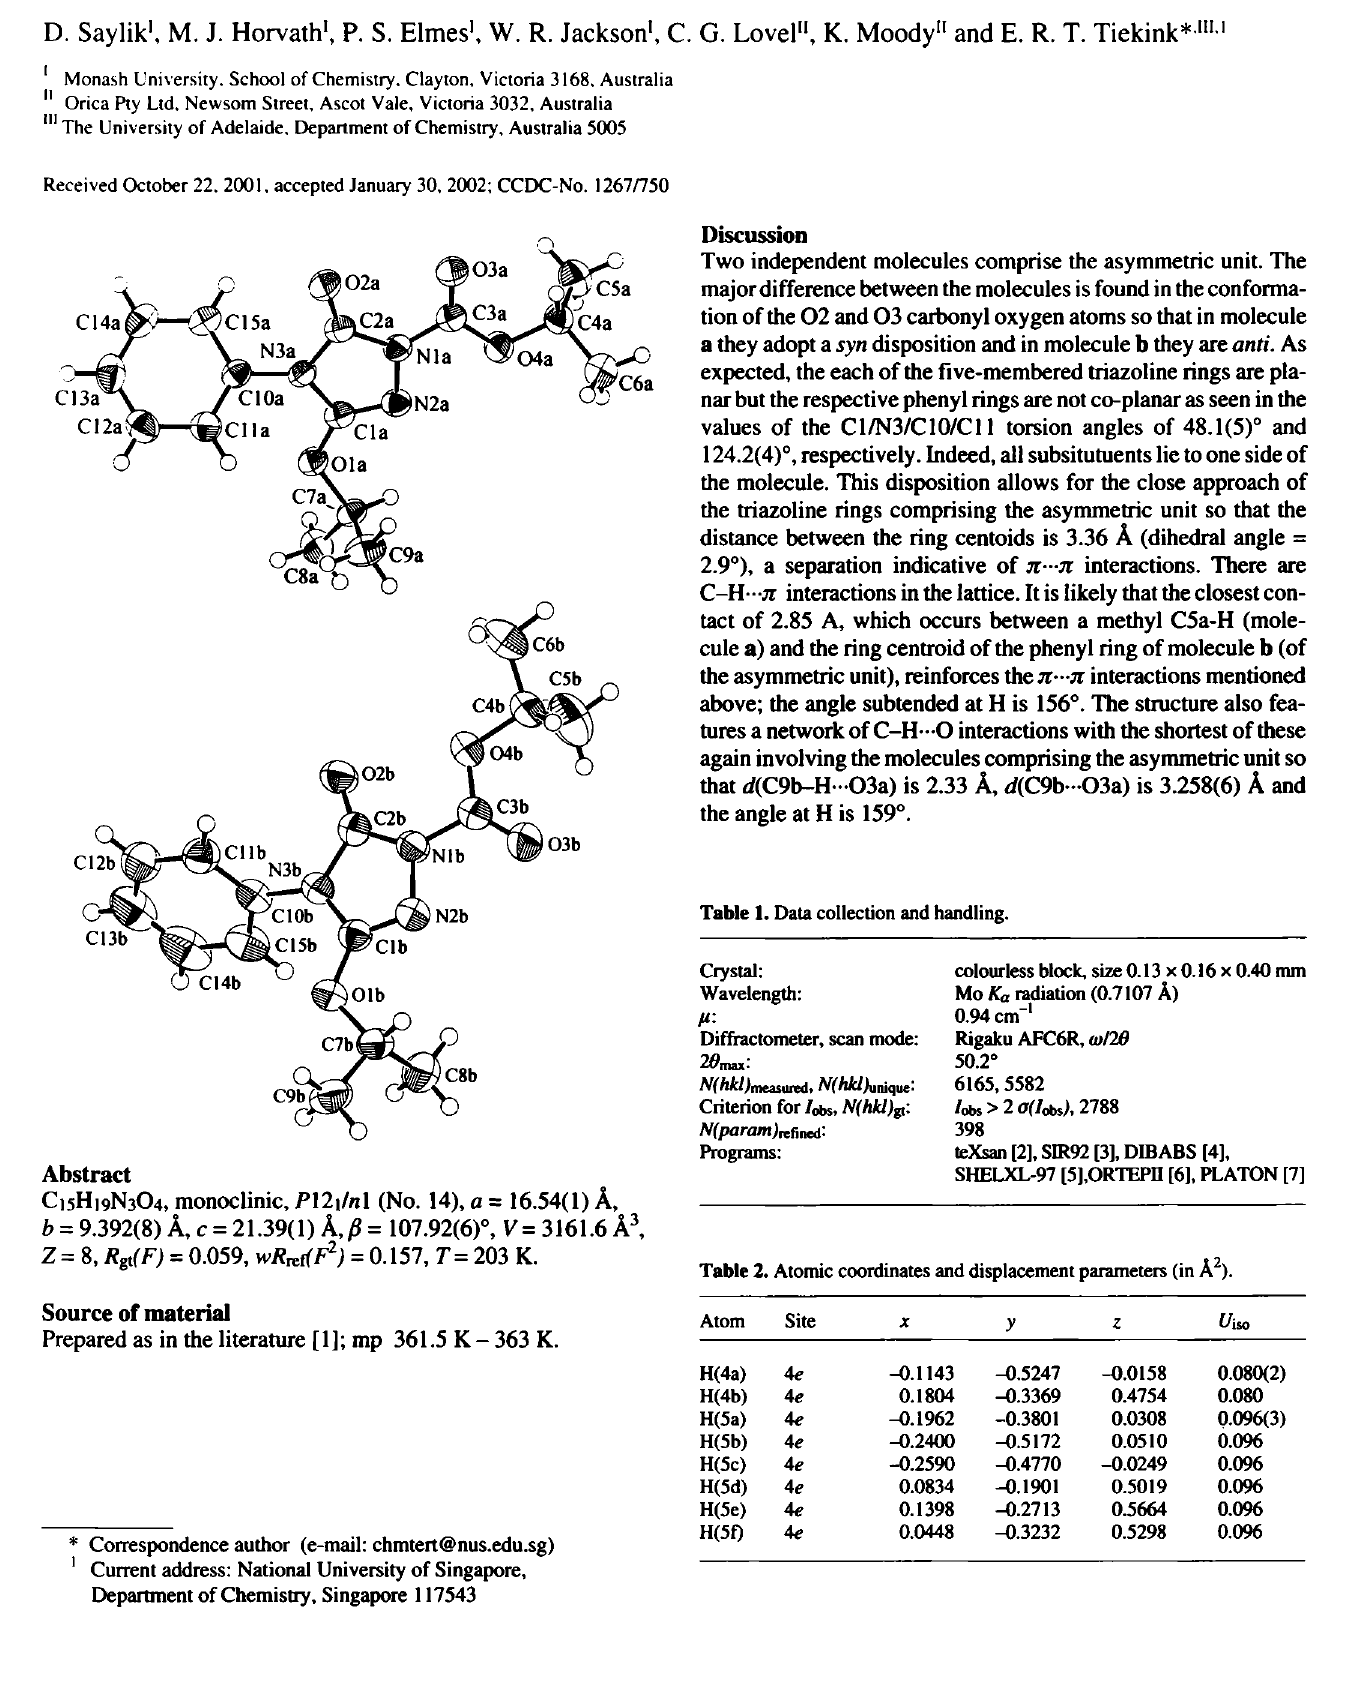
Table 1. Data collection and handling.